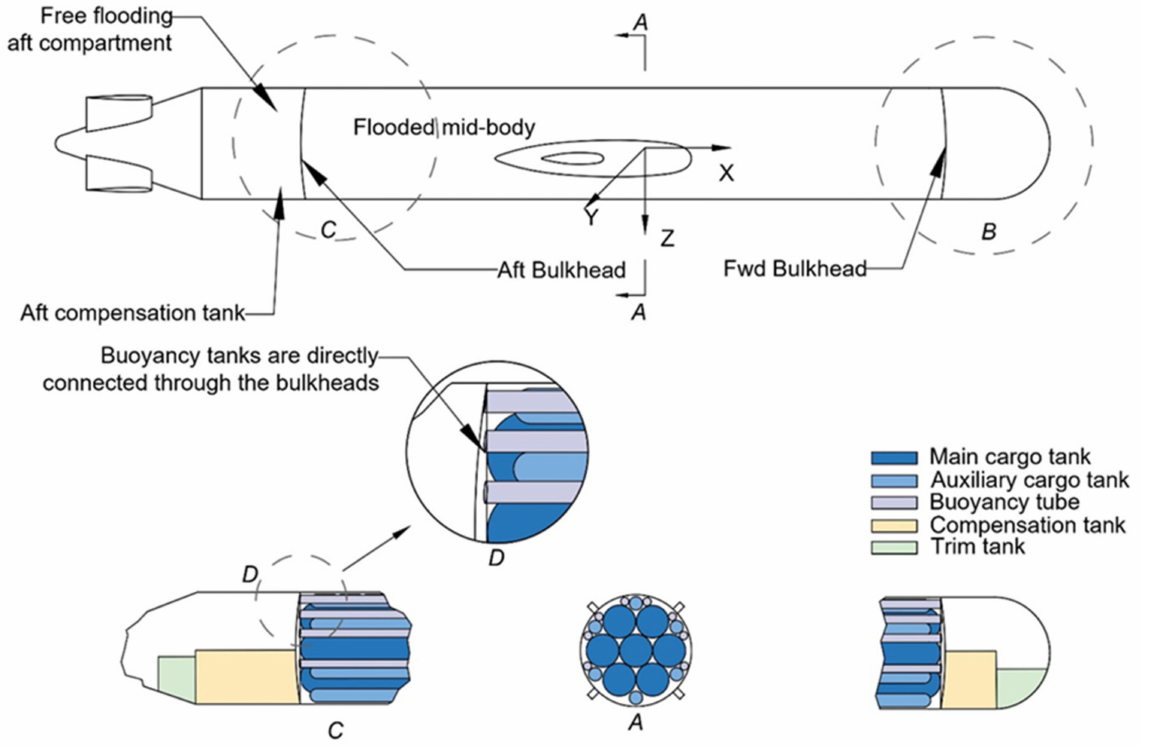
Figure 4. General arrangement of the